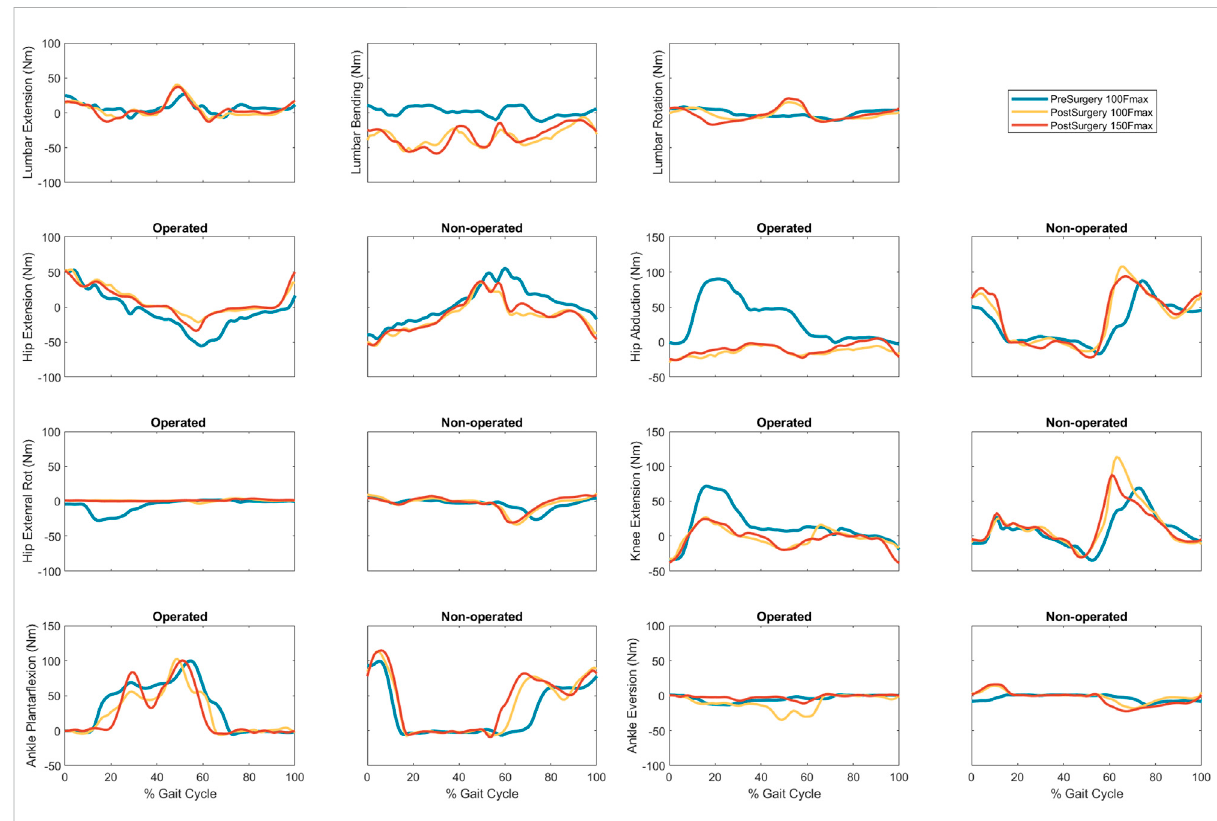
FIGURE 6 Experimental pre-surgery and predicted post-surgery joint moments for post-surgery psoas strengths of 100%, and 150% of the pre-surgery value. The gait cycle begins with operated leg heel